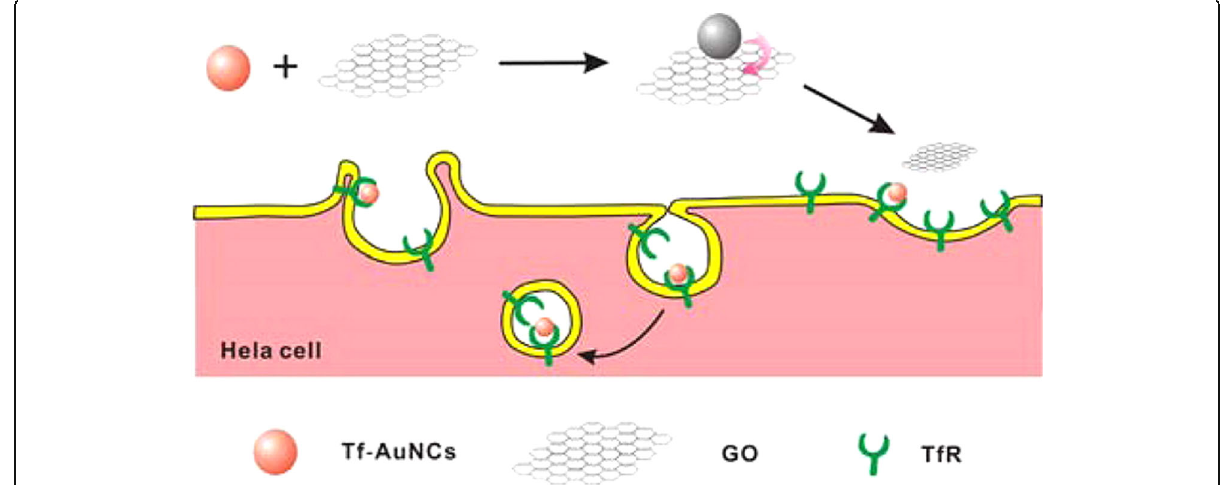
Fig. 8 Fabrication of the Tf-AuNCs/GO conjugation as a turn-on NIR fluorescent probe for bioimaging in cancer cells with TfR over expression